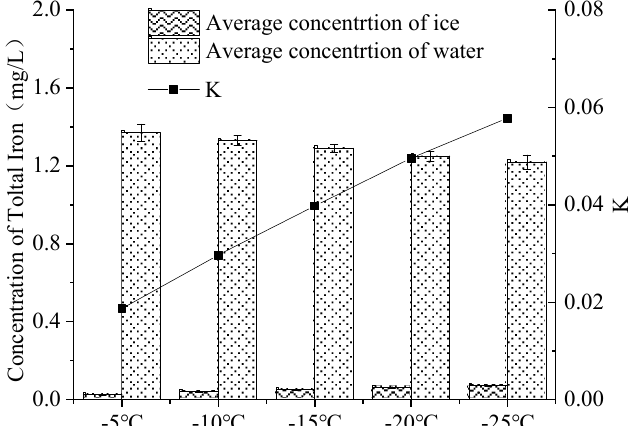
Figure 8. Distribution of iron at varying freezing temperatures in the ice–water system. (Error bar: Mean ± S.D., K: the ratio of the average concentration of iron in the ice to that in the under-ice water).